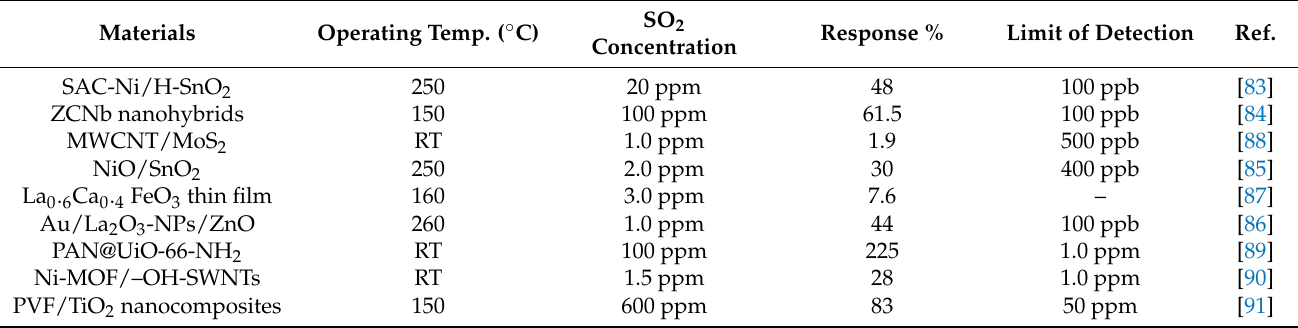
Table 3. The most recent chemiresistive SO 2 sensors reported in the